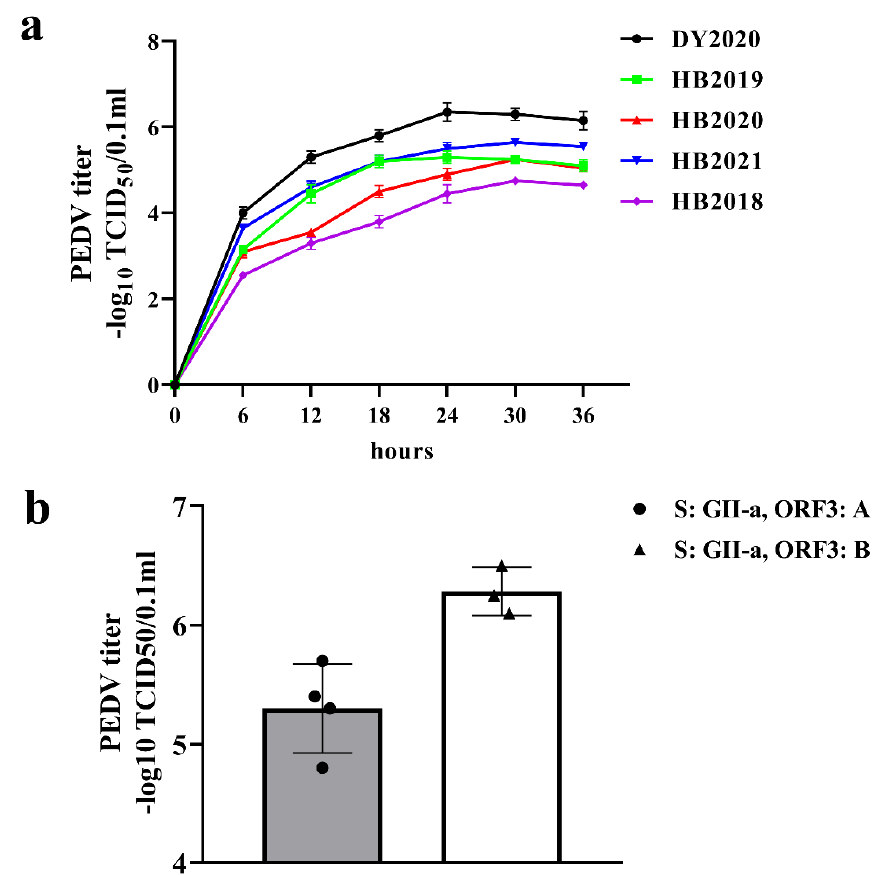
Figure 6. The growth kinetics of isolated PEDV strains and titer analysis . ( a ) Growth curves of isolated PEDV strains in Vero cells. ( b ) The relationship between PEDV strain titer and ORF3 gene clustering. The dots represent HB2018, HB2019, HB2020, and HB2021 strains, and the triangles represent DY2020, HM2017, and CH/HLJ/18 strains [23,24].